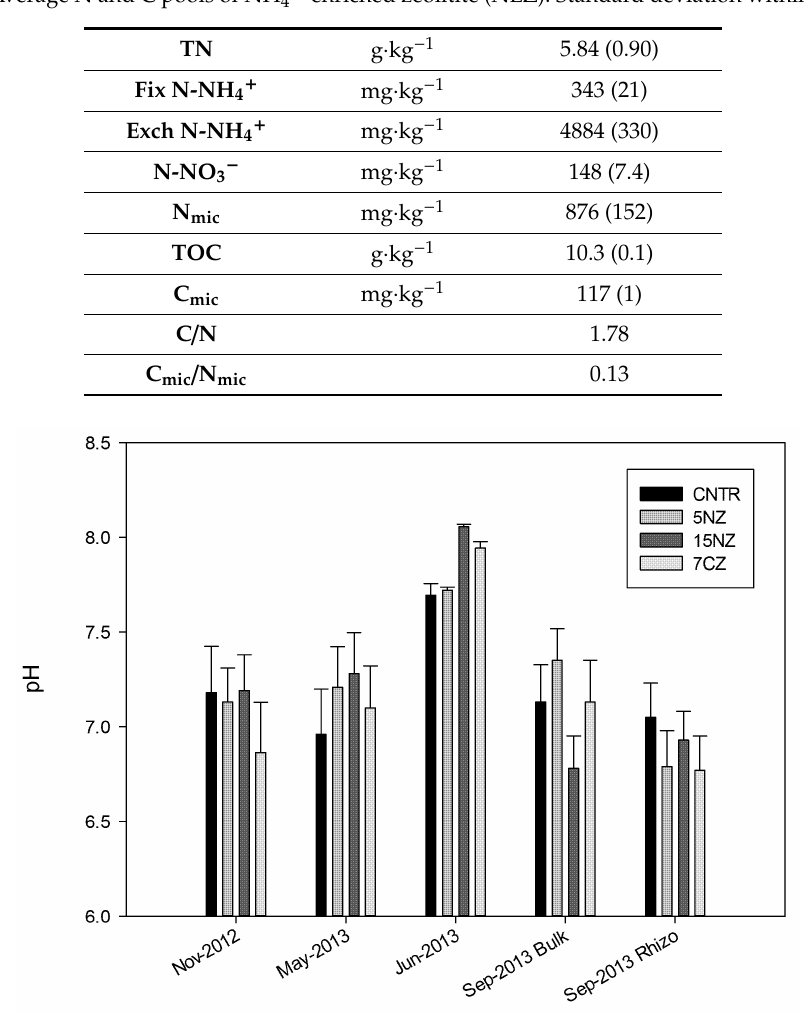
Figure 3. Mean soil pH for each treatment. Error bars represent standard deviation. Table 2. Average of exchangeable bases and cation exchange capacity (CEC) of soil samples, both bulk soil and rhizosphere. Standard deviation within brackets. Significant (p<0.05) or non-significant (p>0.05) differences between treatments at each sampling time are indicated by capital letters.